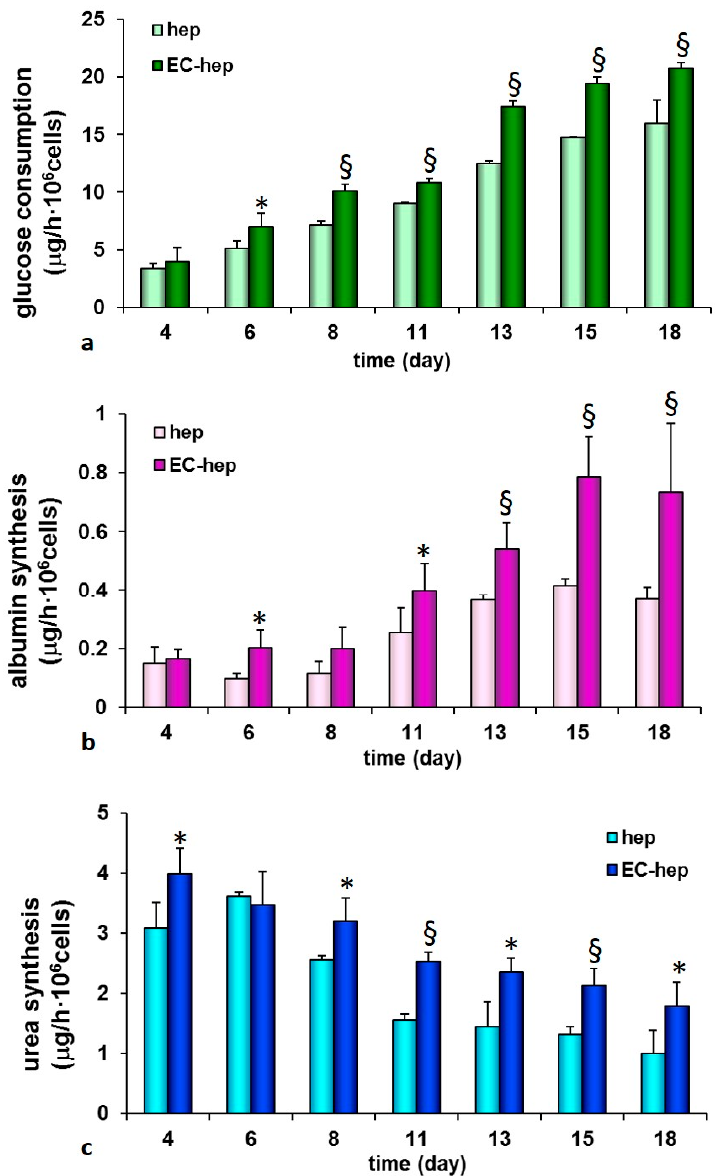
Figure 7. Glucose consumption ( a ), albumin ( b ) and urea ( c ) synthesis by primary human hepatocytes cultured in the PCL HF membrane bioreactor with human endothelial cells (EC-hep) in comparison to homotypic culture of only hepatocytes (hep). The values are the mean ± standard deviations of three experiments per configurations. Data statistically significant according Student t -test: (*) p < 0.05; (§) p < 0.01.